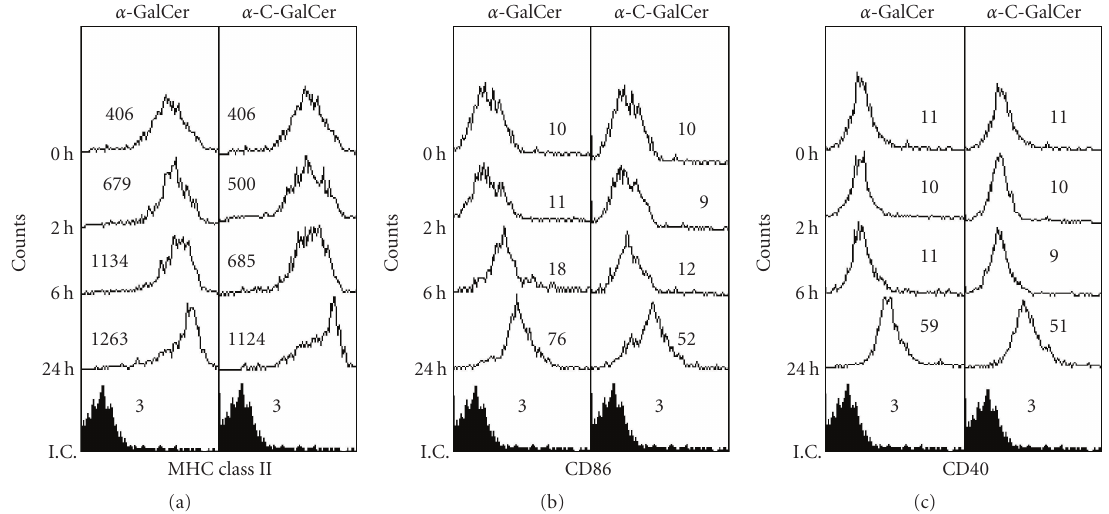
Figure 4: α -C-GalCer induces a prolonged in vivo maturation of DCs compared to α -GalCer. Groups of 3WT mice were injected i.p. with 1 μ g α -GalCer or α -C-GalCer, or with nothing, and 2, 6, or 24 hours later splenocytes were collected and subjected to FACS analysis. CD11c+ cells were gated and analyzed for their levels of (a) MHC class II, (b) CD86, and (c) CD40 at the di ff erent time points after glycolipid administration. Also shown are isotype control stainings obtained from the maximally activated, 24-hour, α -GalCer-treated splenocyte populations, gated on CD11c+ cells. The numbers next to each histogram tracing represent the mean fluorescence intensity for that tracing. The data shown come from one of four experiments with similar